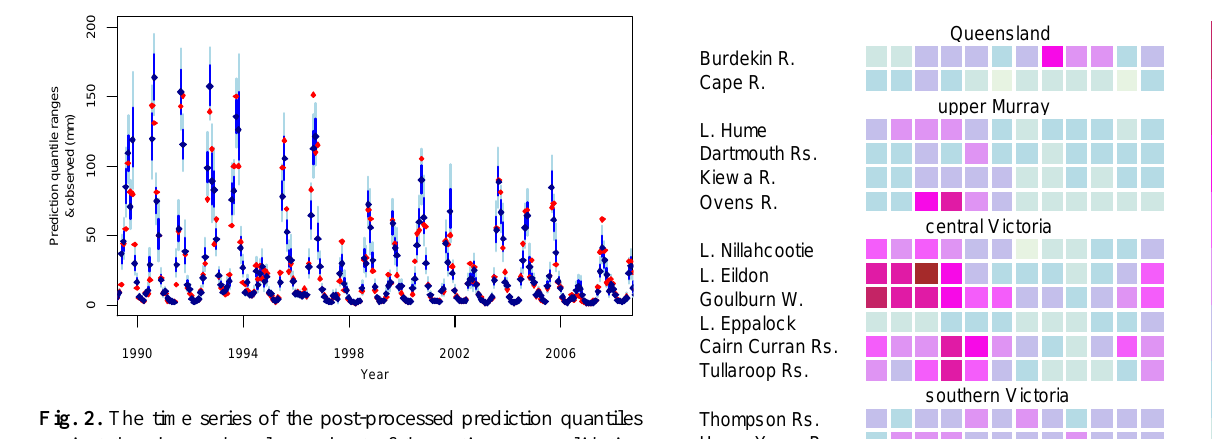
Figure 3: Performance of WAPABA in all 18 catchments in terms of RMSEP values calculated for 477 each month. 478